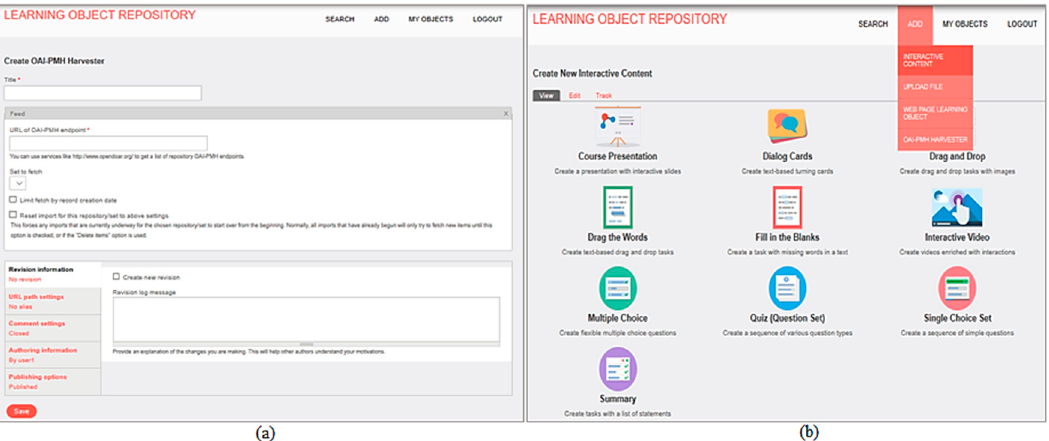
Figure 6. Multifunctional platform: ( a ) ELO search process; ( b ) ELO design and adaptation process.